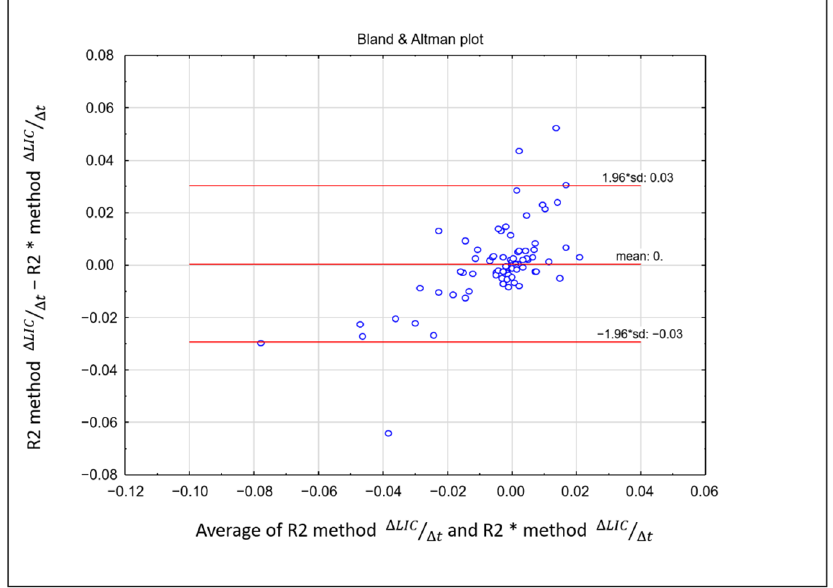
Figure 5. Bland–Altman difference plot demonstrating the difference between the rate of change of liver iron concentration obtained from R2 and R2* methods on the y-axis and the mean of the rate of change from the two methods on the x-axis. The majority of the plotted variables were between the two standard deviations.